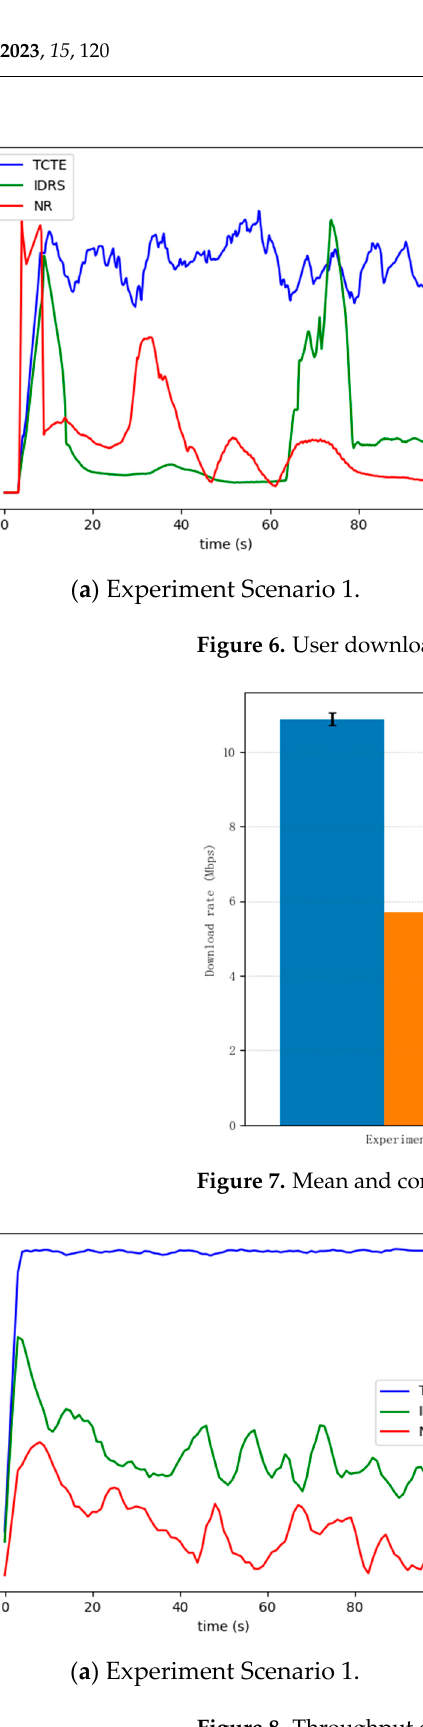
Figure 8. Throughput of edge